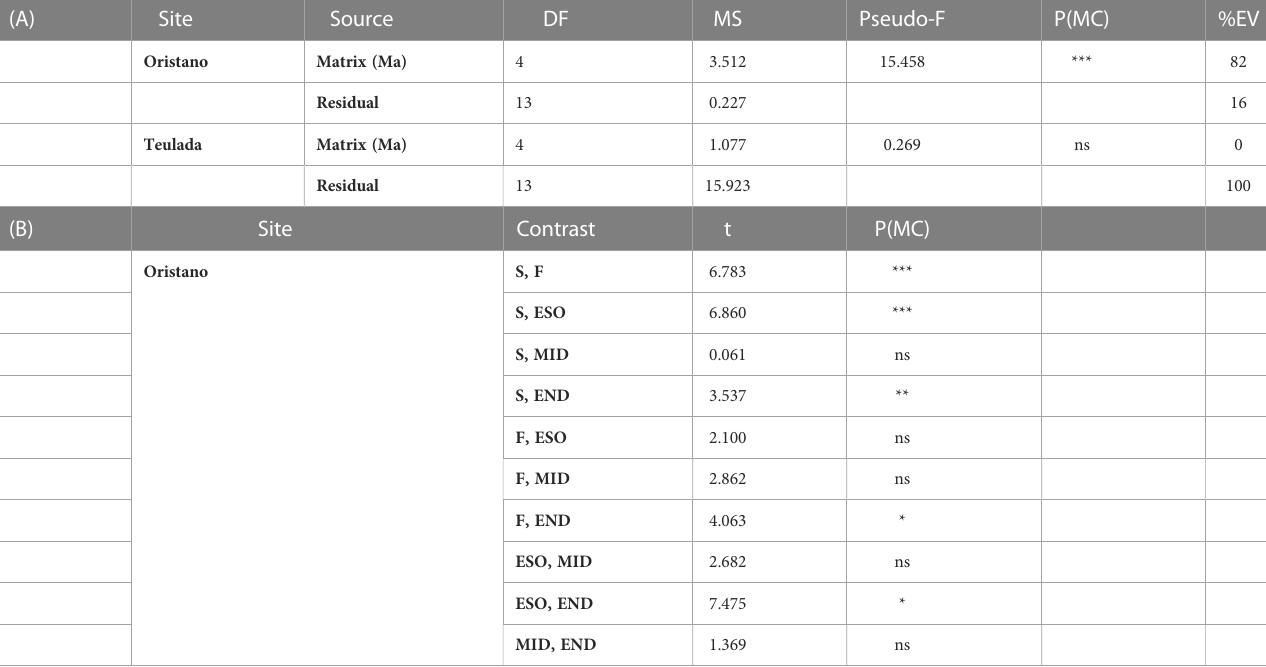
TABLE 4 Results of the univariate PERMANOVA testing differences in the protein content of the source sediment, digestive tract and feces of H. tubulosa in the two study sites (A); and results of the pairwise comparison testing for difference in protein contents in the source sediment (S), digestive tracts (esophagus = ESO; mid gut = MID; end gut = END) and feces (F) in the meso-eutrophic site (Oristano) (B).